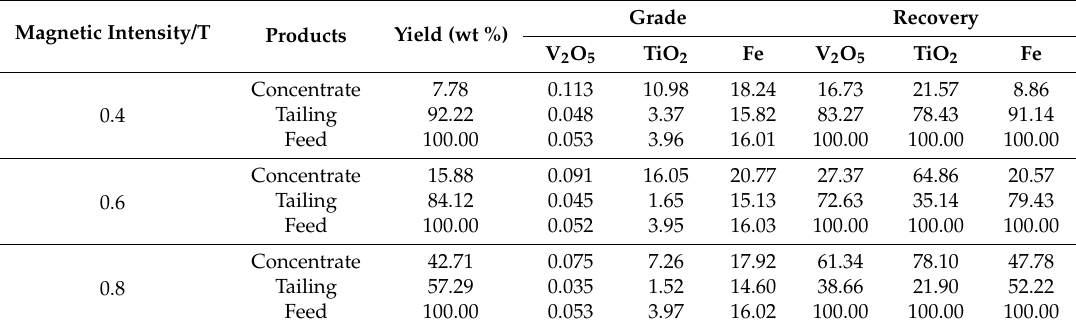
Table 7. The results of magnetic intensity tests by high-intensity magnetic separation.